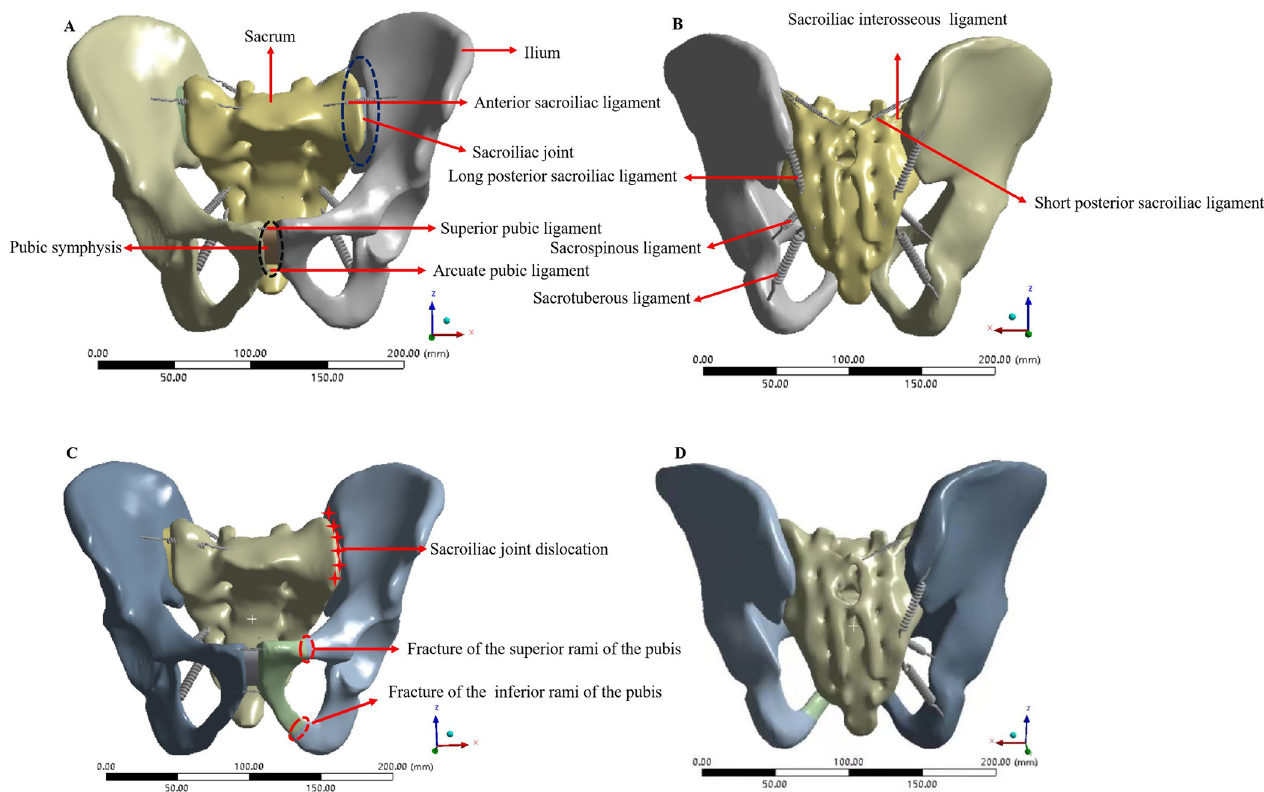
Fig 1. Construction of the FE models of normal pelvis and A Tile C1 fractured pelvis. (A) Anterior view of the FE model of the normal pelvis. (B) Posterior view of the FE model of the normal pelvis. (C) Anterior view of the FE model of the Tile C1 fractured pelvis. (D) Posterior view of the FE model of the Tile C1 fractured pelvis.